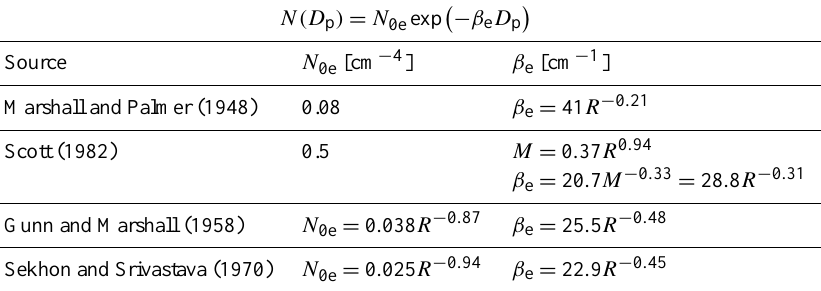
Table 2. List of exponential snow-particle number size distributions. Actual snow-particle size was used in Scott (1982) (see Appendix A), whereas melted snow-particle sizes were used in other formulas. R is precipitation intensity (mmh − 1 ) , and M is precipitation water concen- tration (gm − 3 )